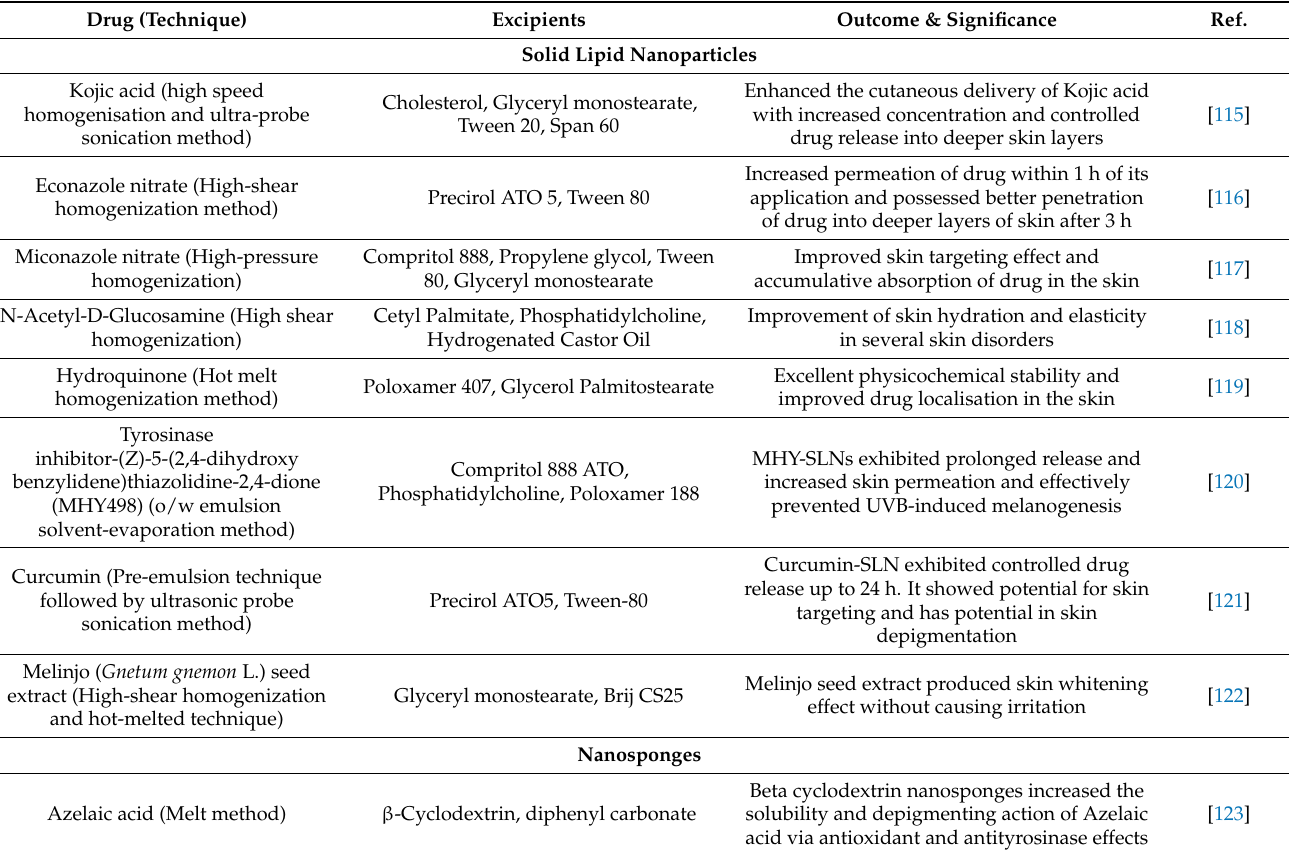
Table 2. The summary of research outcomes of nanocarriers based topical drug delivery explored for the management of melasma and other hyper-pigmentation